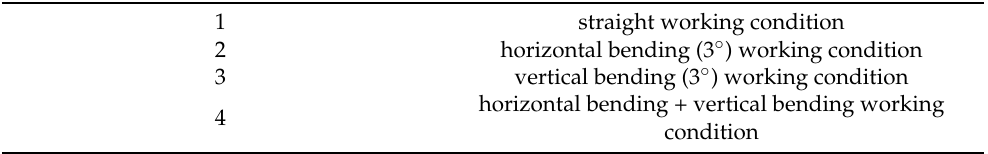
Table 2. Four typical terrain conditions of the scraper conveyor test